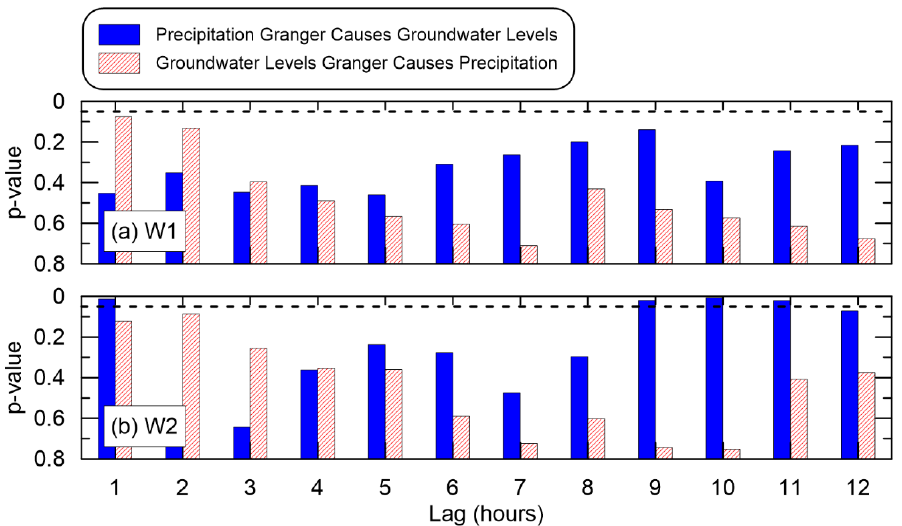
Figure 13. Results from Granger causality tests on wells ( a ) W1 and ( b ) W2 with respect to precipitation.